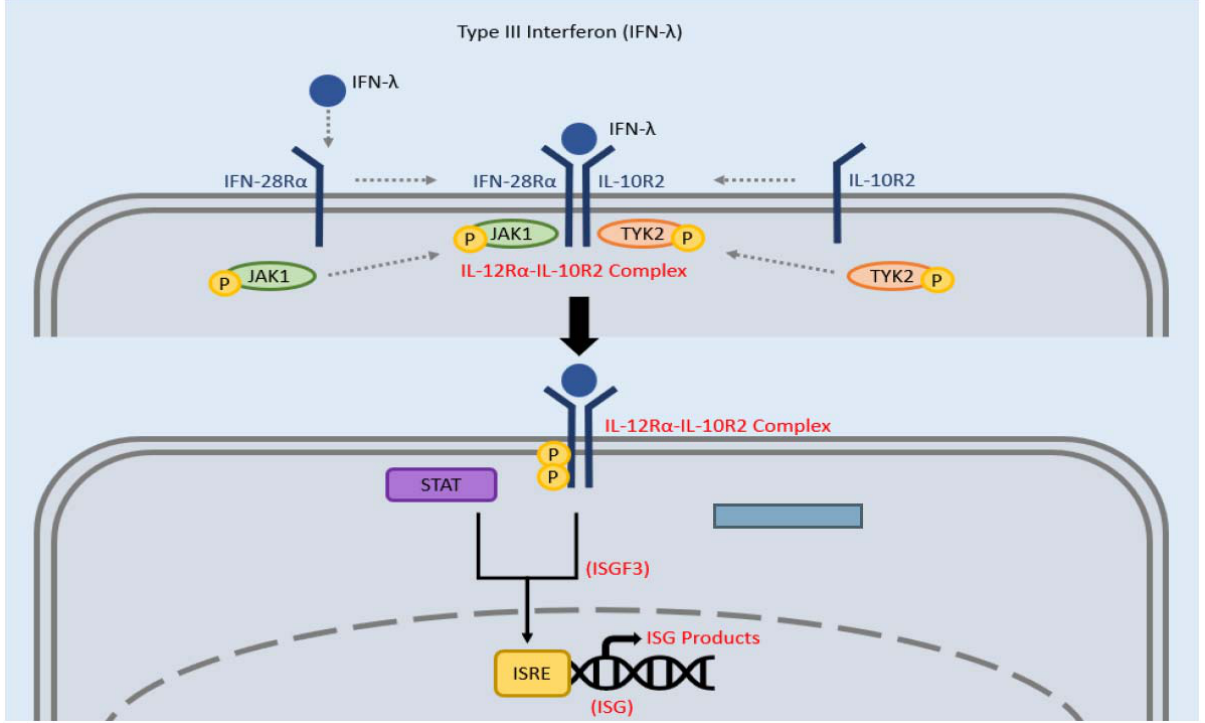
Figure 4. Signaling pathway of type III IFN. The receptor is made of two subunits: IFN ‐ 28R α and IL ‐ 10R2. Type III IFN binds to the IFN ‐ 28R α receptor which leads to a conformational change, resulting in the addition of IL ‐ 10R2. JAK1 and TYK2 then phosphorylate the intracellular domain of IFN ‐ 28R α , allowing STAT to recognize it and bind and form a complex known as ISGF3. This ISGF3 complex moves into the nucleus and bind to the promoter region of ISG, known as ISRE, leading to IFN ‐ stimulated gene products.